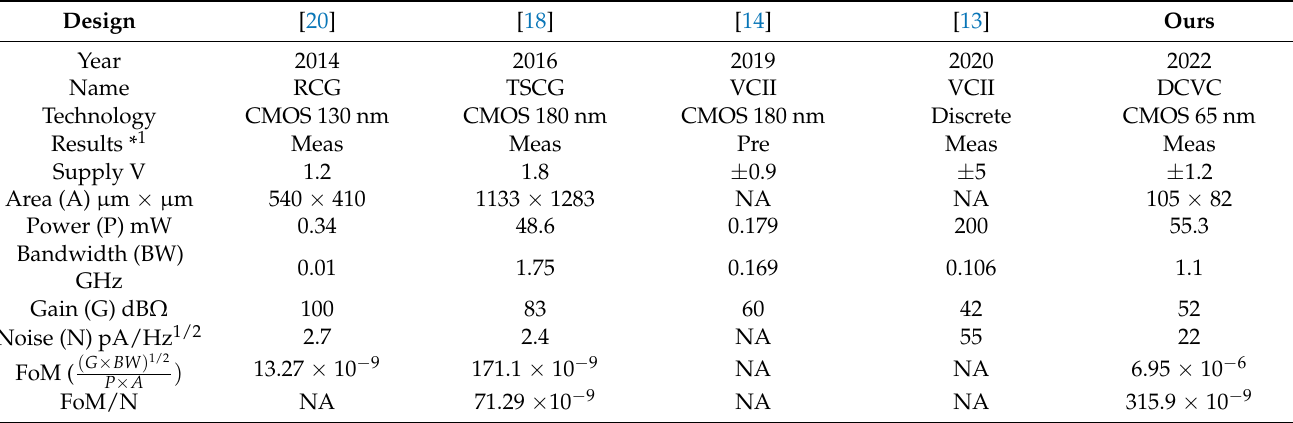
Table 3. Comparison between circuit design approaches proposed in the